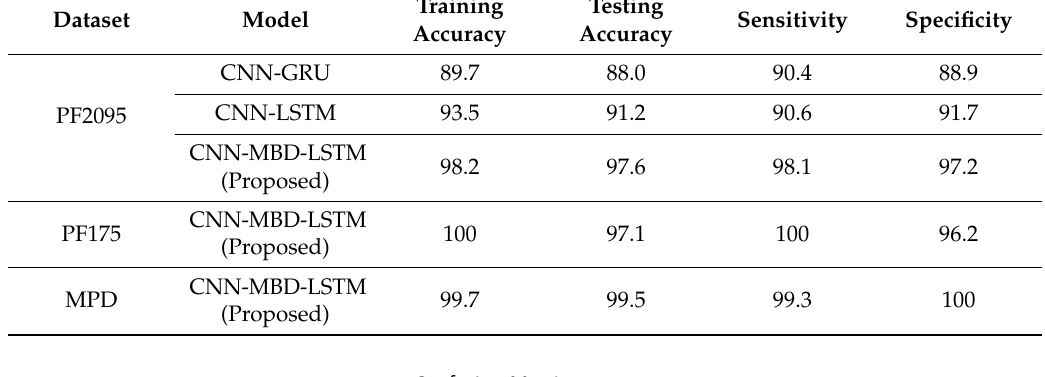
Table 3. Training and testing performance of the MPPIF-NET on di ff erent models and datasets.